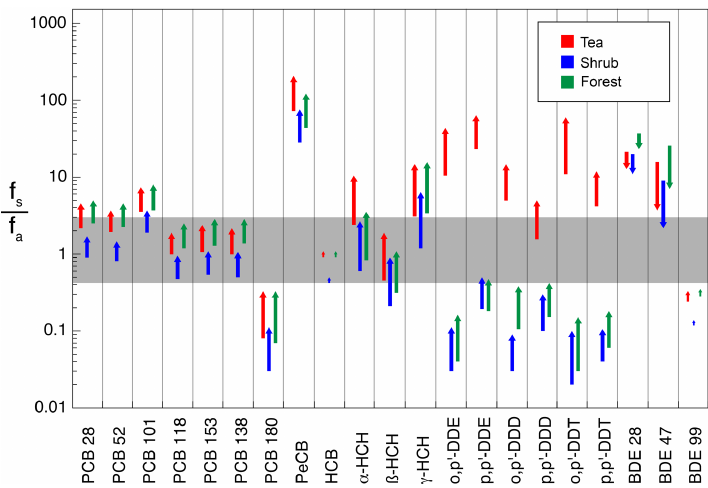
Figure 2. Change in air–soil chemical equilibrium with the monsoon onset. Arrows denote direction and amount of change in the fugacity ratio, f s /f a , over various soils from prior to posterior onset. f s /f a <1 denotes downward (net deposition) while f s /f a >1 denotes upward (net volatilisation) flux. The shaded zone (0.33< f s /f a <3) indicates insignificance of deviation from 1 due to input data uncertainties.